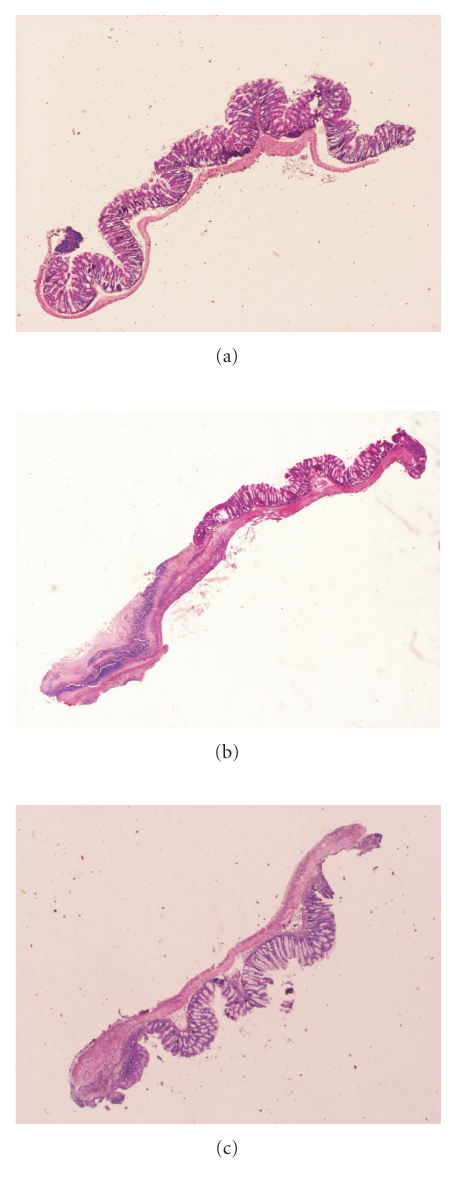
Figure 4: Histological appearance of mouse colonic tissue. Rep- resentative samples of colon after hematoxylin and eosin staining are shown. (a) Sham group; (E): no evident histological modi- fication. (b) Mice with TNBS-induced colitis; (D) a wide range of histopathological changes including necrosis of epithelium, de- struction of glands, and infiltration of inflammatory cells in the mucosa and submucosa (up to 50% of colon section). (c) Mice treated with 0.2% thyme and 0.1% oregano oils; (B) intermediary histopathological changes (up to 30% of colon section).